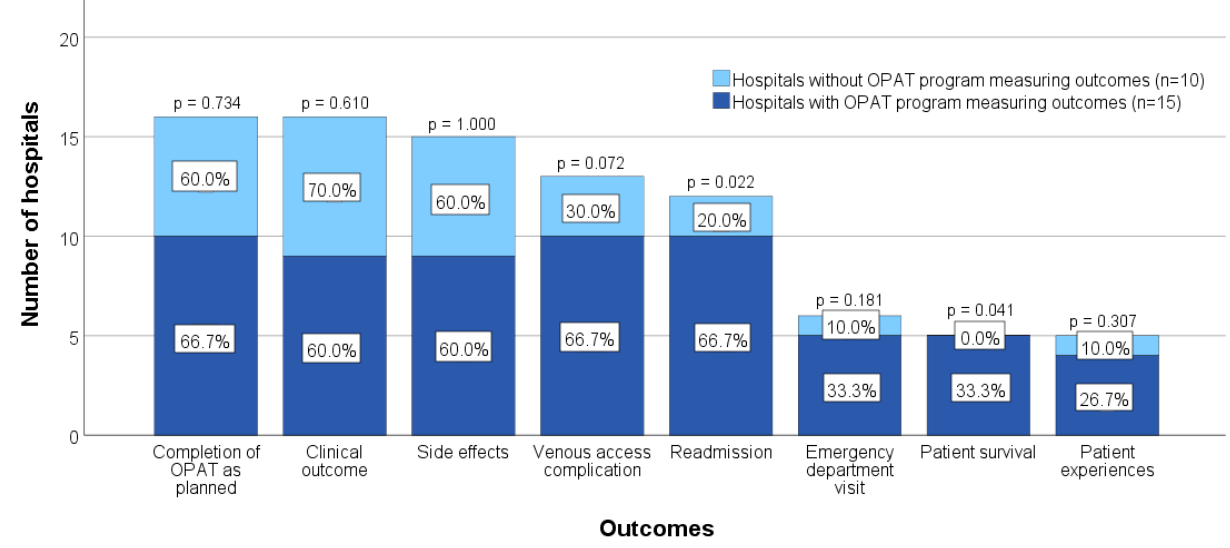
Figure 1. Comparison of outcomes measured by hospitals with and without an OPAT program. The percentages represent the proportion of hospitals with or without a program measuring the specific outcome, and the p -value is the significance of the comparison between these proportions.